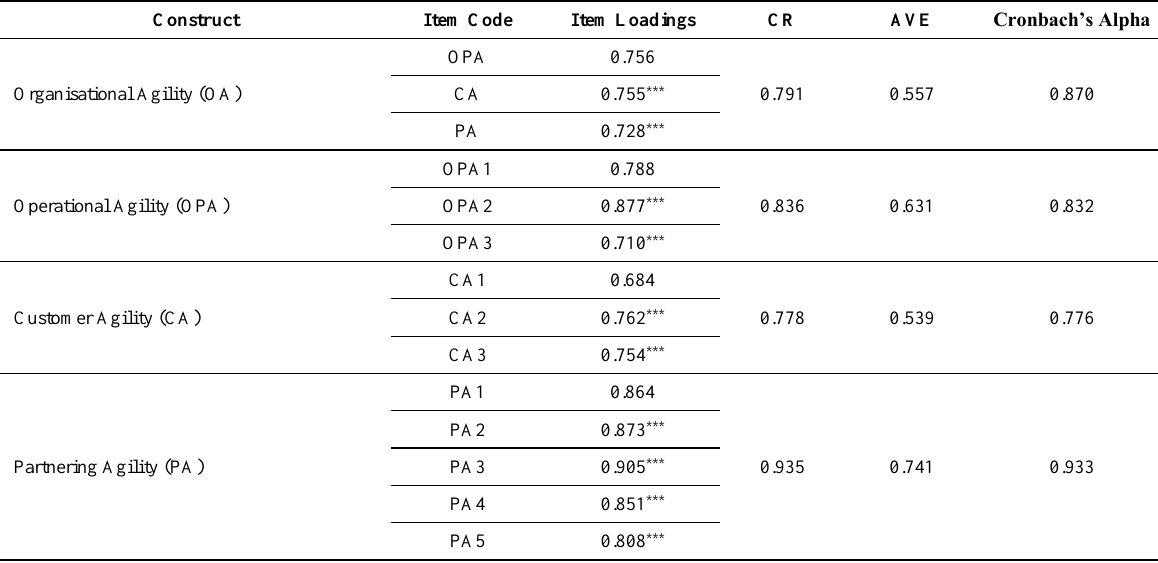
Table 3. The factor loadings, Composite Reliability (CR), Average Variance Extracted (AVE) and Cronbach’s